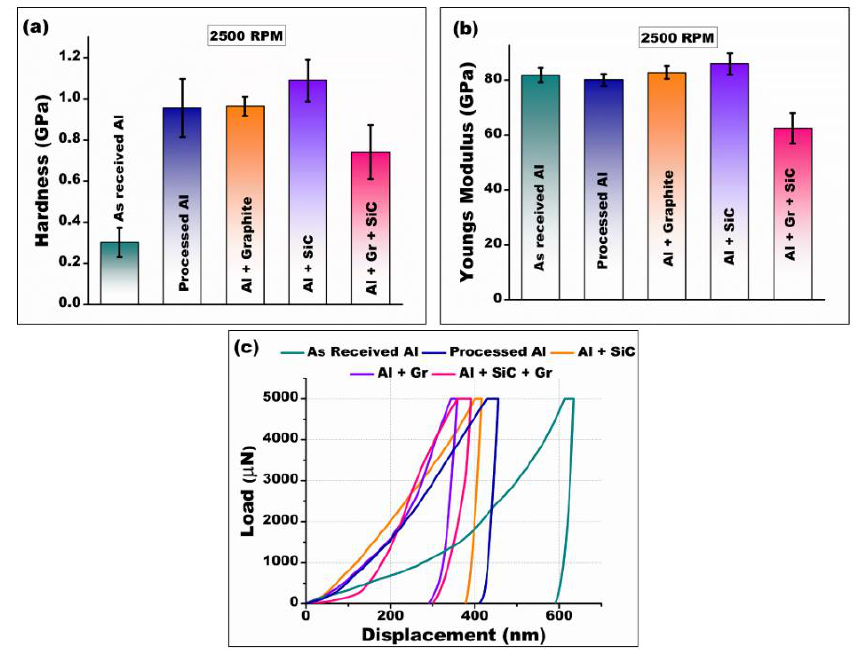
Figure 10. Comparison of ( a ) nano-hardness, ( b ) Young’s modulus, ( c ) load vs. displacement curve at 2200 rpm. Graphite is abbreviated as